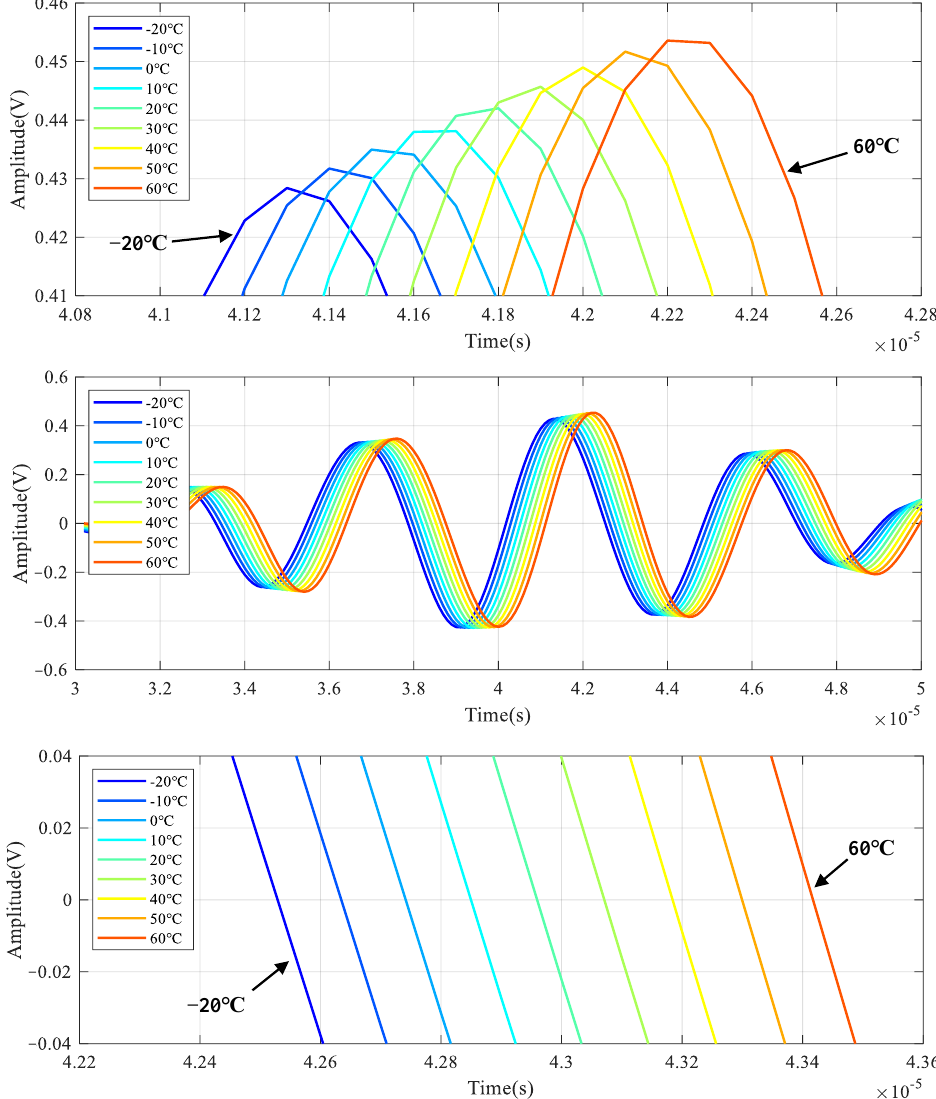
Figure 6. Typical LW response signal results of simulation under temperature effect.